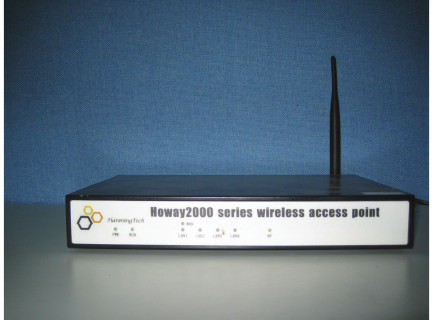
Figure 2: Access